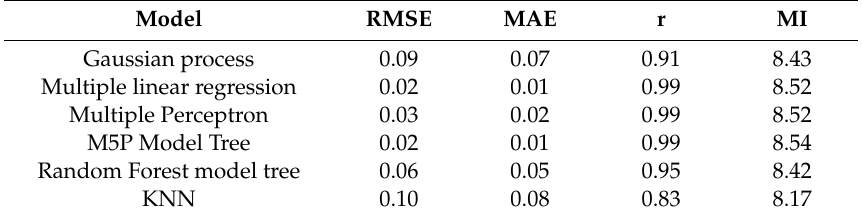
Table 6. Summary of performance of multiple ML models with training data from 2008 to 2012.